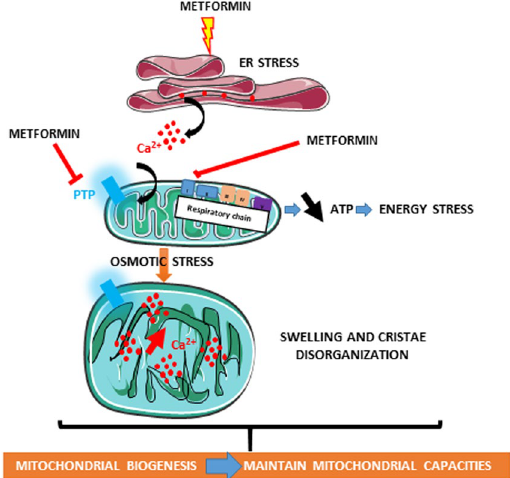
Figure 5. Schematic representation of the effects of metformin on mitochondrial biology in cancer cells. The illustrations were created by adopting templates from Servier Medical Arts (http://www.servier.fr/smart/ banque-dimages-powerpoint) which are free for use under the terms of the Creative Commons 3.0